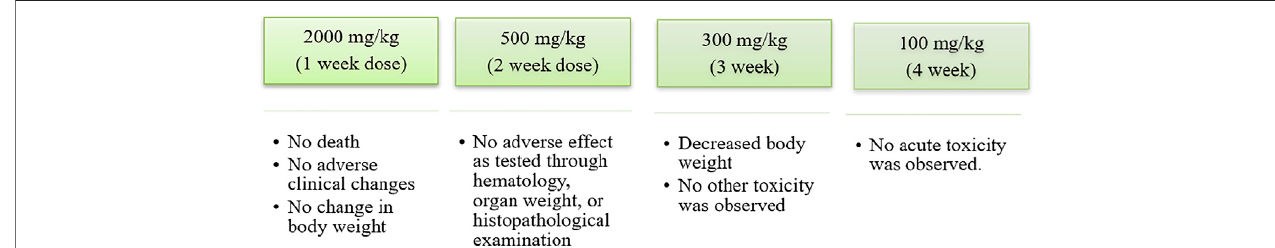
FIGURE 11 | Toxicology study of shikonin on beagle dog (Nam et al., 2015).